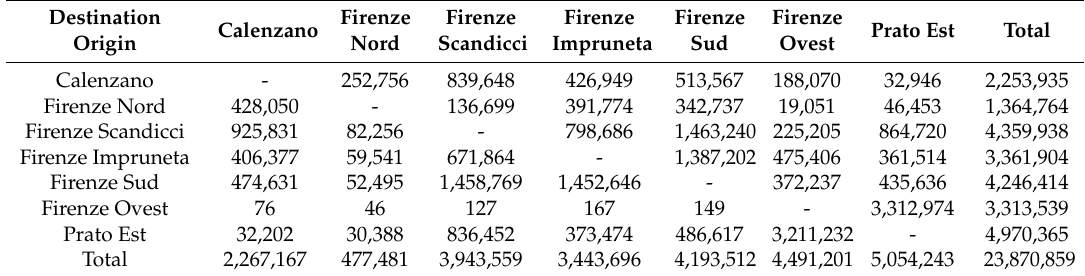
Table 1. Vehicular flows in the Florence area in 2014 (source: Autostrade per l’Italia S.p.a.). Destination